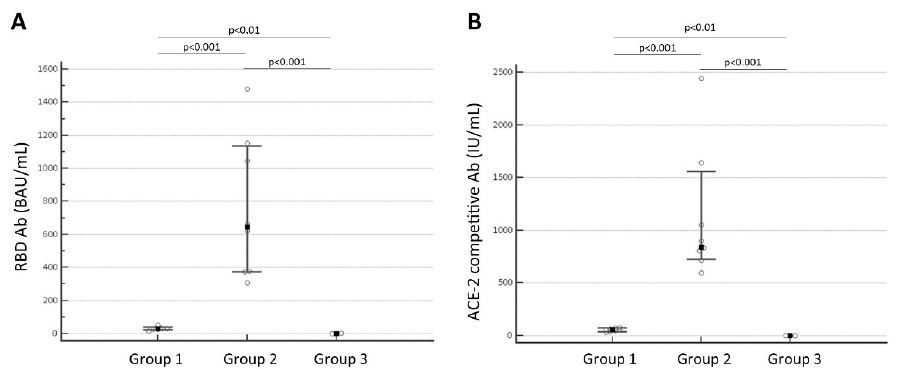
Figure 1. ( A ) The RBD antibodies levels of the three groups that were analyzed (Group 1 median value 28.898 BAU/mL, Group 2 median value 645.295 BAU/mL, Group 3 median value 0.562 BAU/mL). There was a significant difference between Group 1 and Group 2 ( p < 0.001), between Group 1 and Group 3 ( p < 0.01), and between Group 2 and Group 3 ( p < 0.001). ( B ) The ACE2RBD-ACE2 blocking antibody levels of the three groups that were analyzed (Group 1 median value 56.550 IU/mL, Group 2 median value 836.816 IU/mL, Group 3 median value 2.16 IU/mL). There was a significant difference between Group 1 and Group 2 ( p < 0.001), between Group 1 and Group 3 ( p < 0.01), and between Group 2 and Group 3 ( p < 0.001).